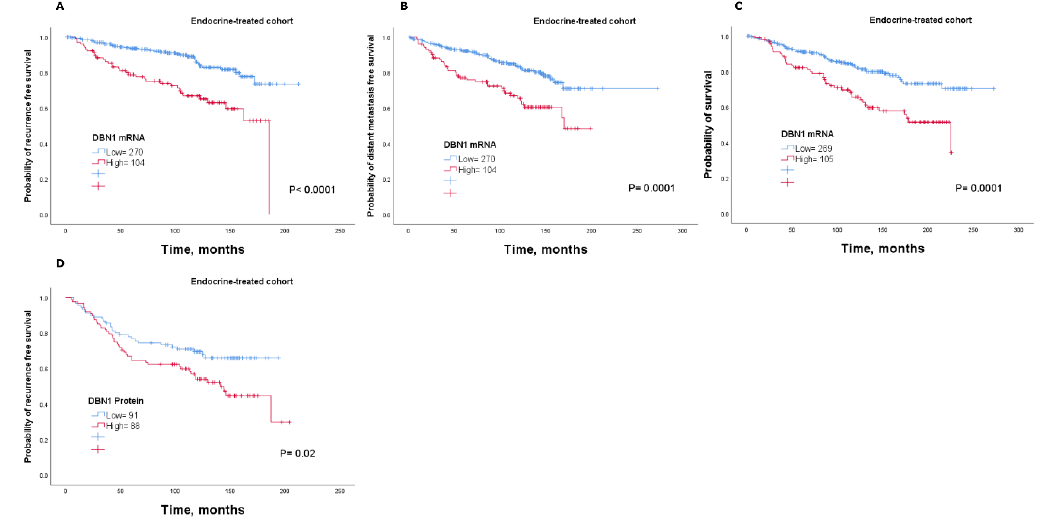
Figure 4. Association of DBN1 mRNA and DBN1 protein with patient outcome in luminal breast cancer who received adjuvant endocrine treatment only using the METABRIC cohort: ( A ) recurrence, ( B ) distant metastasis and ( C ) survival; and using the Nottingham cohort: ( D ) recurrence. DBN1 protein results were consistent with the mRNA, whereby patients who were subject to endocrine treatment and with high expression had a higher risk of recurrence compared to patients with low expression ( p < 0.05; Figure 4D). Cox regression analysis revealed that both the DBN1 mRNA and DBN1 protein levels are predictive markers for a higher risk of relapse in the subgroup of patients who were treated with endocrine therapy alone ( p < 0.05; Table 2). Table 2. Multivariate cox analysis of the associations between DBN1 expression and clinicopathological parameters in patients with luminal breast cancer who received adjuvant endocrine treatment only.